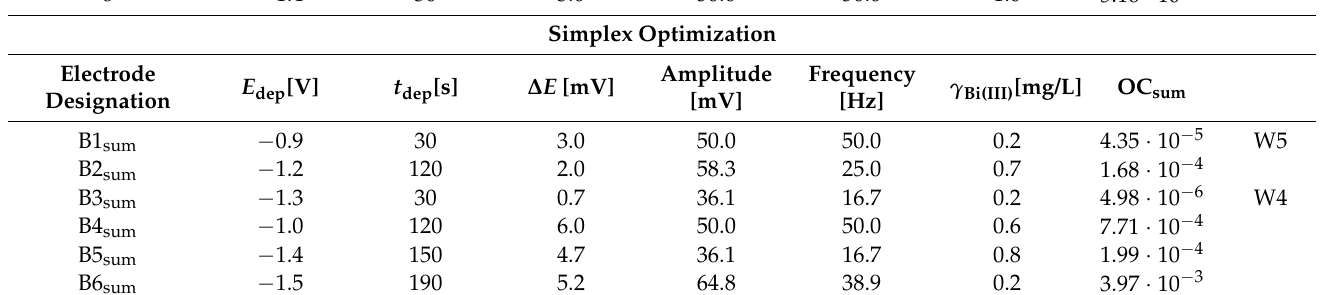
Table 5. The simplex optimization procedure with designated Wi and Bi, when OC sum is taken as the OC.